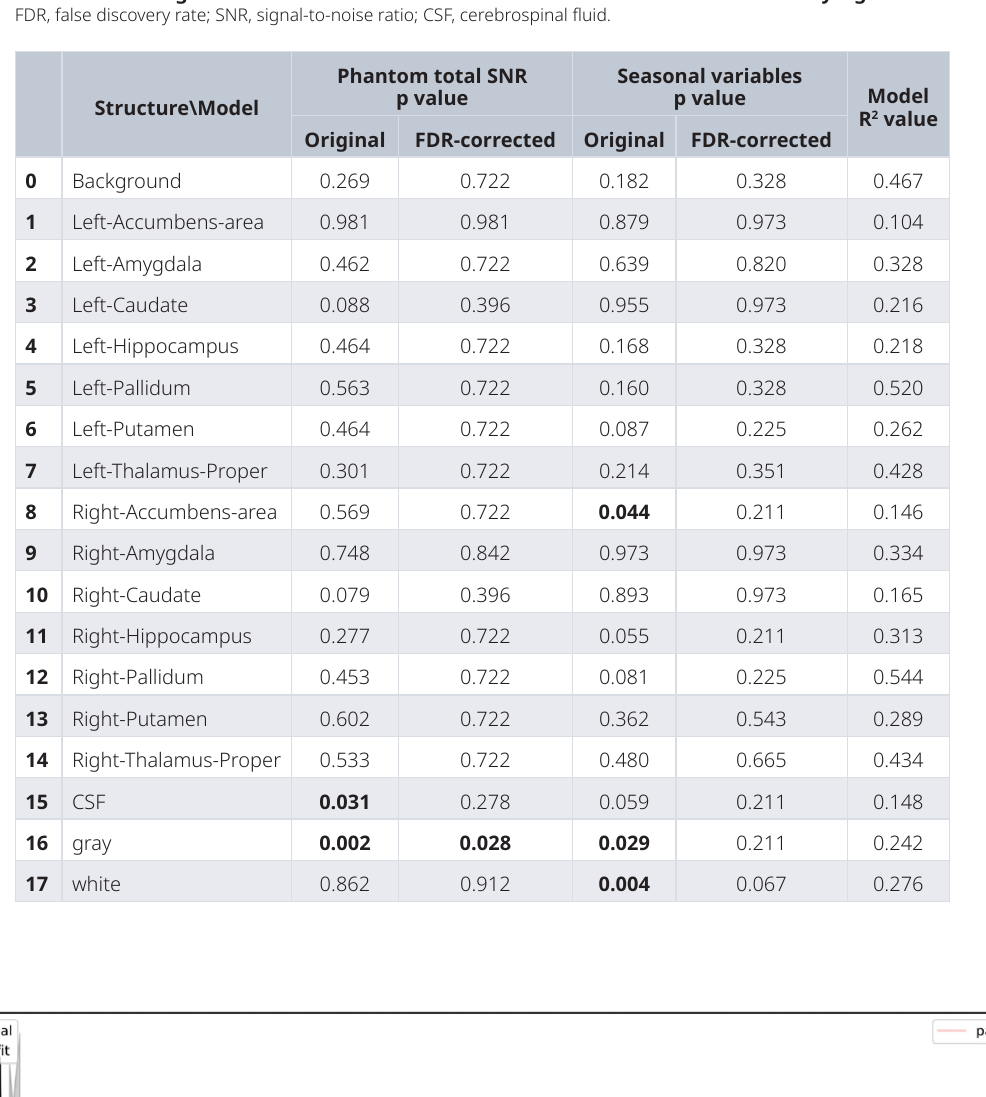
Table 4. Brain segmentation statistics results where bolded values are statistically significant. FDR, false discovery rate; SNR, signal-to-noise ratio; CSF, cerebrospinal fluid.